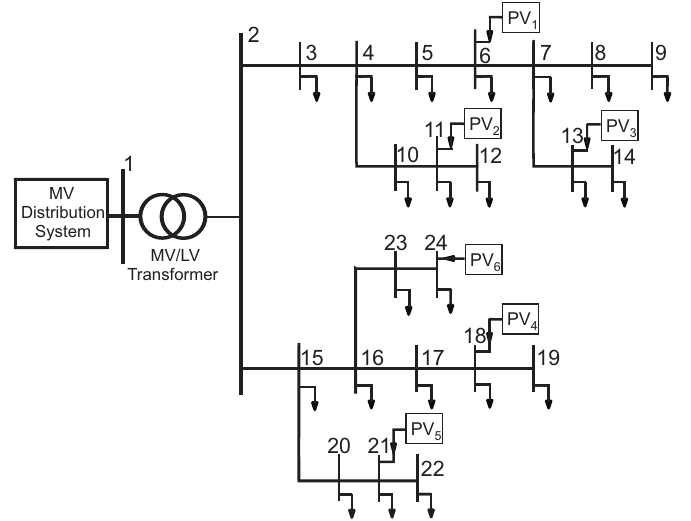
Figure 5. LV distribution system including six PV